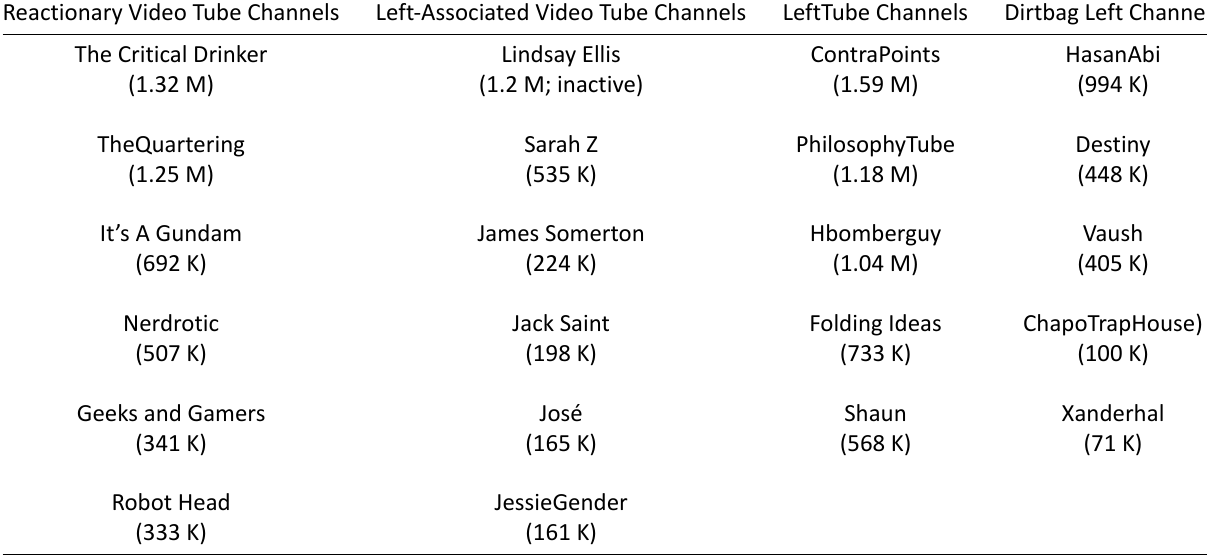
Table 1. Central channels observed, with the number of subscribers in millions (M) and thousands (K), as of August 2022. Reactionary Video Tube